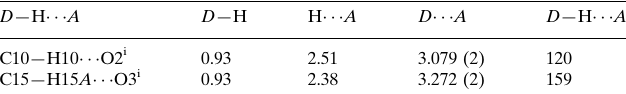
Hydrogen-bond geometry (A˚ , (cid:2)